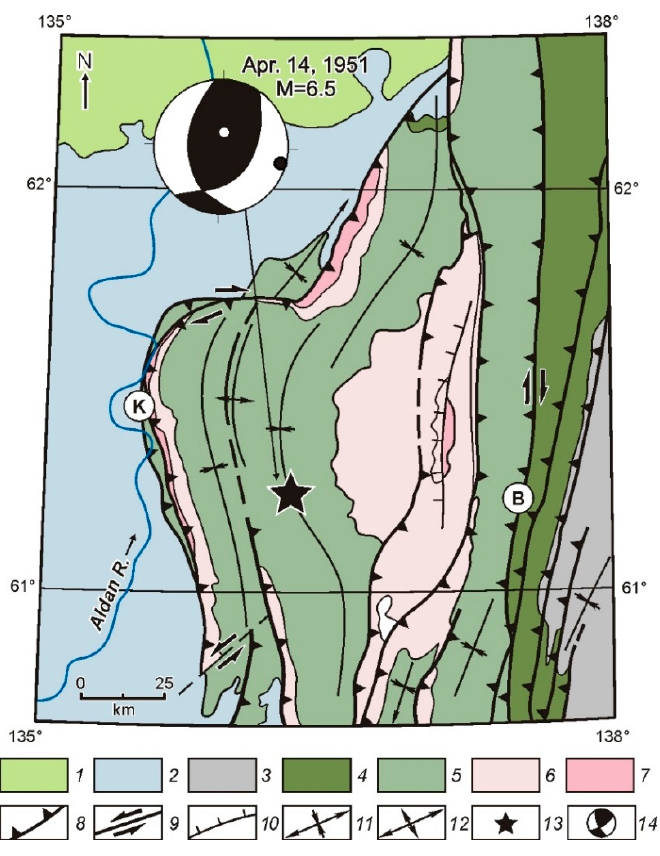
Figure 11. Structural dynamics of the Kyllakh block, South Verkhoyansk sector (modified after [27,32]).